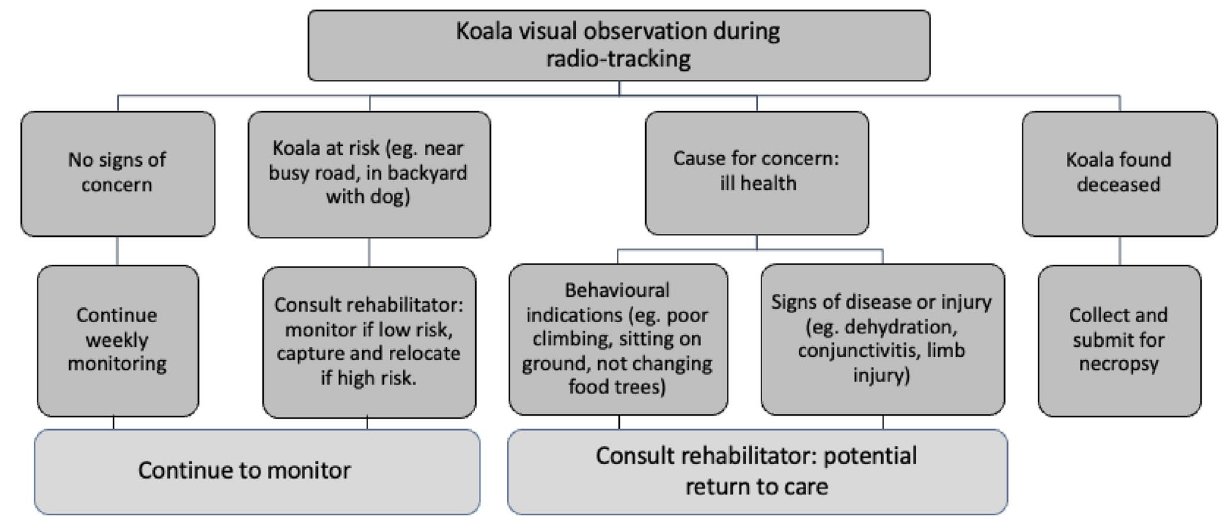
Figure 2. The decision-making process if any causes of concern or risks to koalas were encountered during weekly monitoring and visual inspection by radio